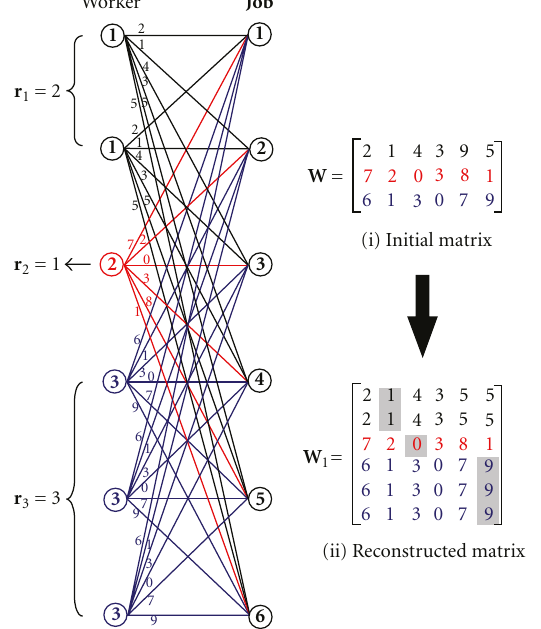
Figure 5: Asymmetric bipartite matching with resource realloca- tion ( n 1 < n 2